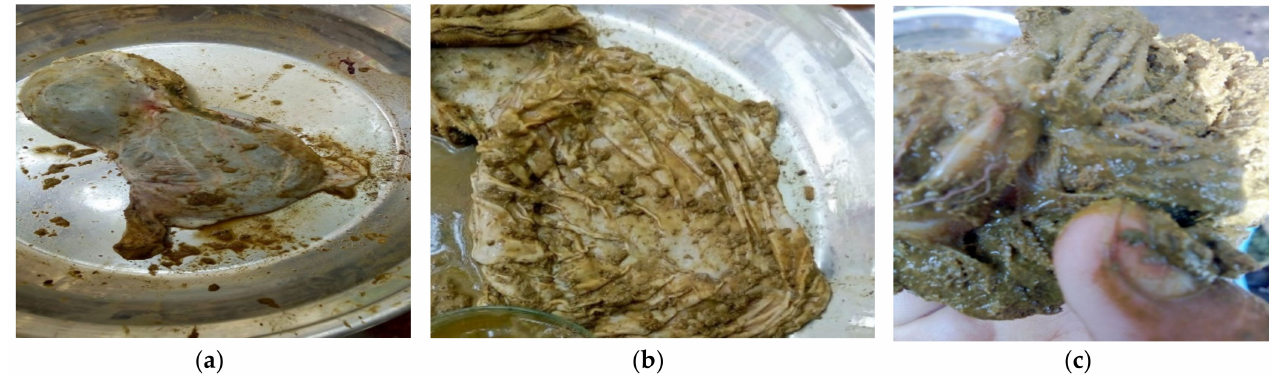
Figure 1. ( a ) Abomasum, ( b ) opened of abomasum, ( c ) adult Haemonchus contortus in